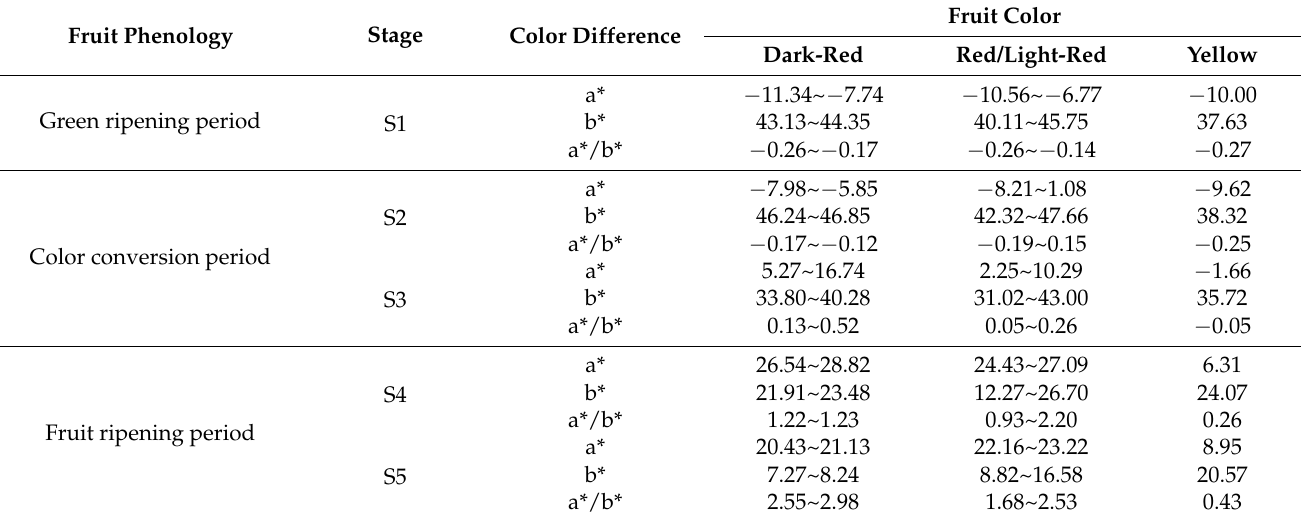
Table 1. Division of fruit phenology of Chinese cherry with different fruit color. Fruit